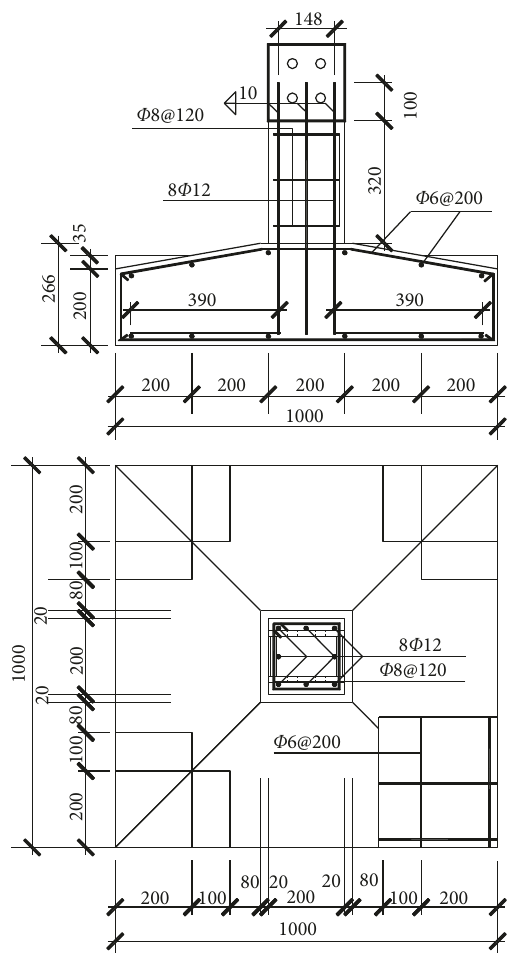
Figure 2: Steel reinforcement of NJ1.